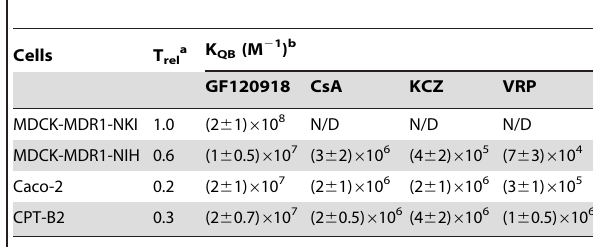
Table 3. Fitted parameter values of efflux active Pgp for each cell line relative to the MDCK-MDR1-NKI line and K QB for the digoxin basolateral transporter from digoxin transport